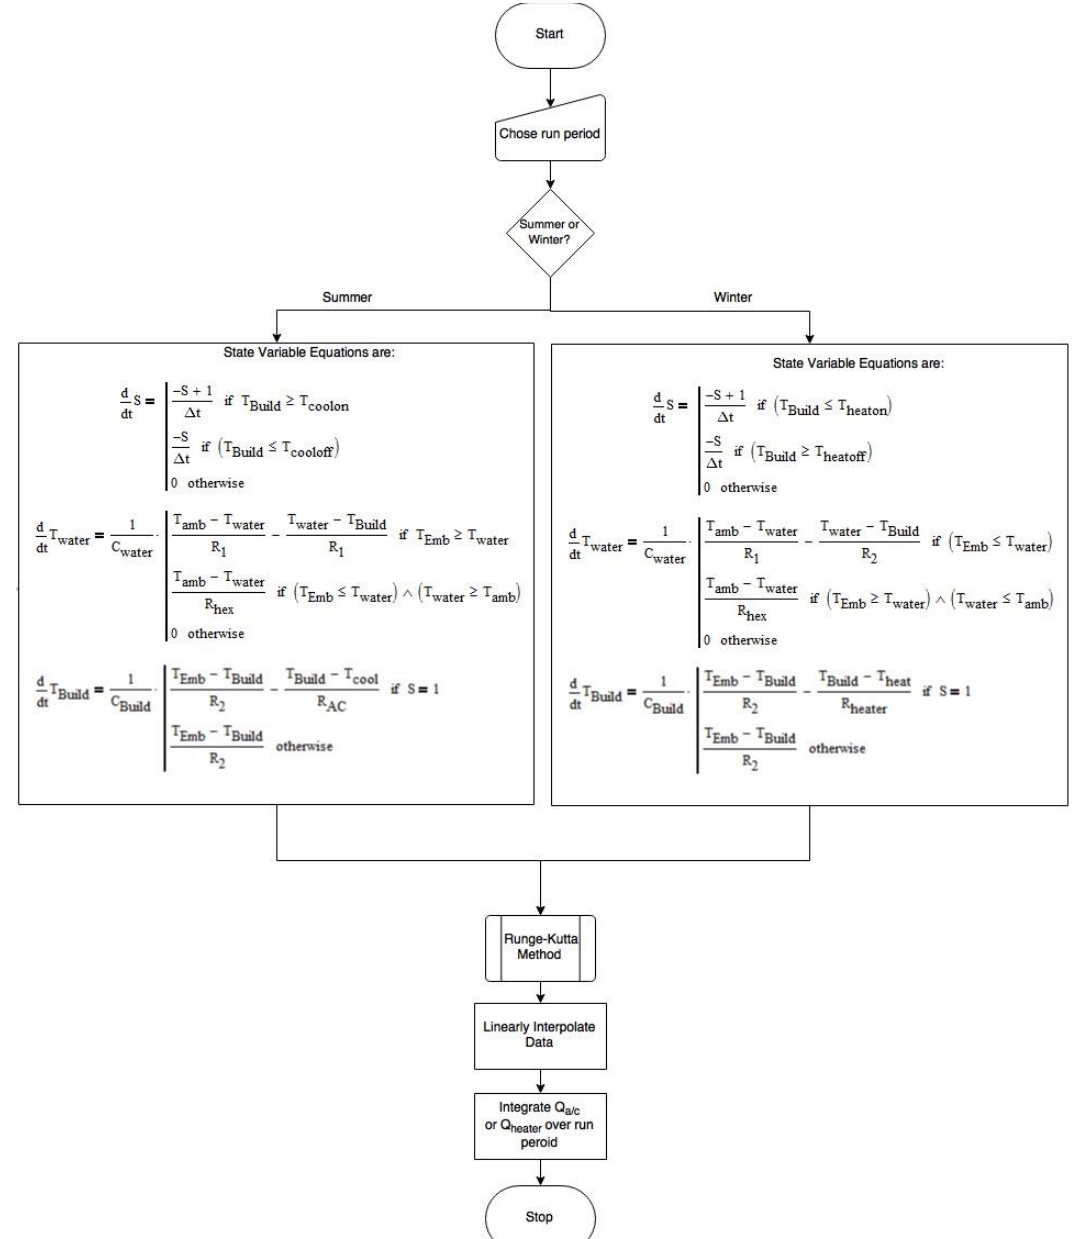
Figure 5. Flowchart for state variable equations for the ITC/TSM